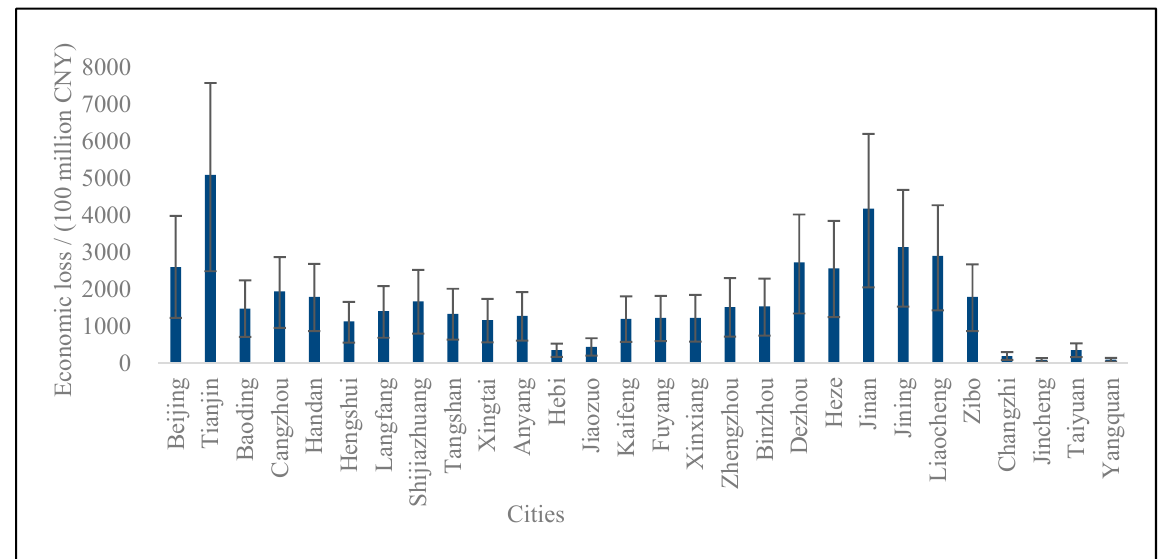
Figure 6. Economic loss of ‘2 + 26’ cities in 2020.